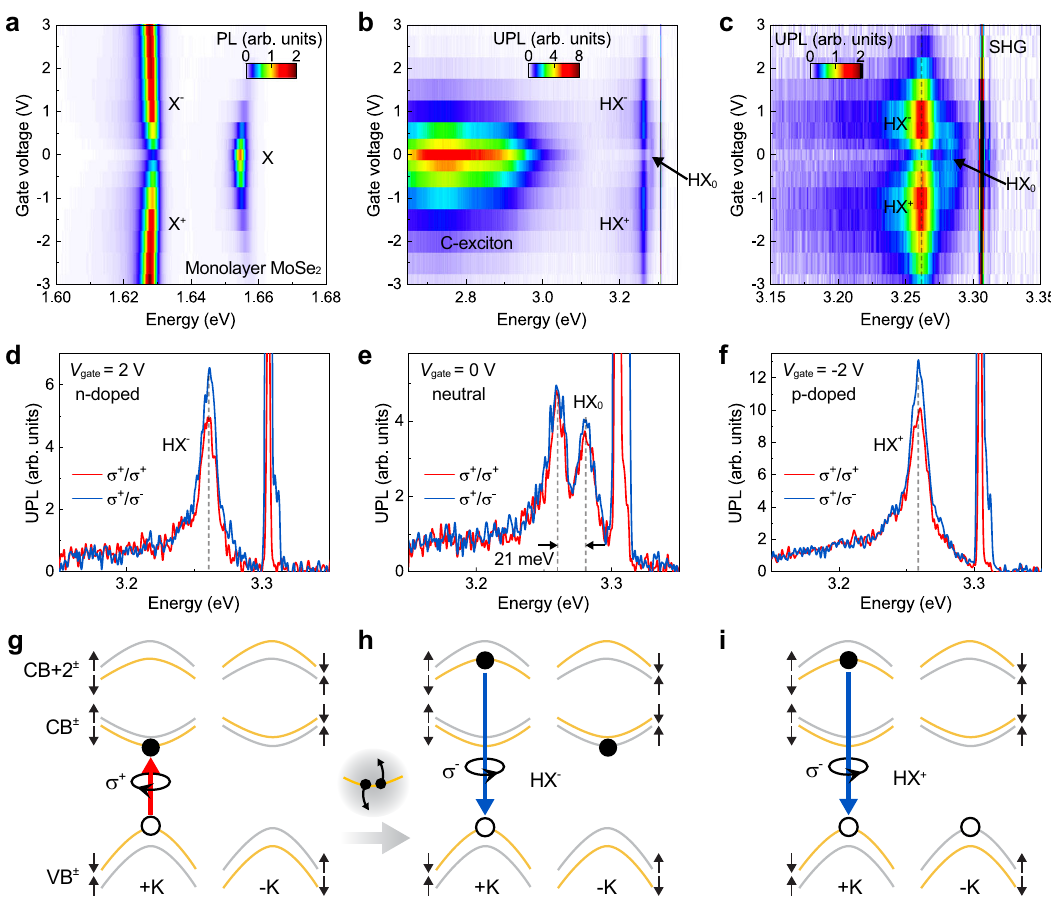
Fig. 3 | High-lying excitons and trions in monolayer MoSe 2 . a Doping dependence of band-edge excitons (X) from monolayer MoSe 2 , measured by the PL as a function of the gate voltage applied to a top graphite electrode. b UPL as a function of gate voltage. The excitation is at 1.654eV in resonance with X. The features attributed to the neutral HX, and the negatively and positively charged HX are marked as HX 0 , HX − , and HX + , respectively. c A rescaledplotofpanelBhighlightingtheHXemission. d – f Polarizationresolved